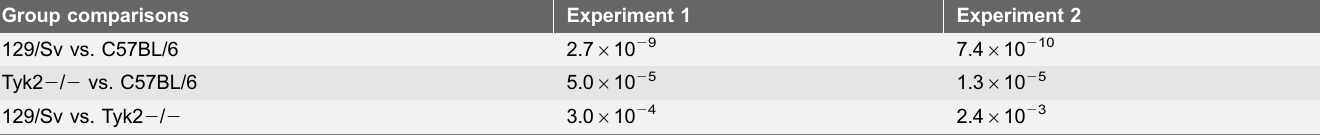
Table 1. ANOVA-pairwise comparison to assess significant differentiation among the three genotypes ( p -values). Group